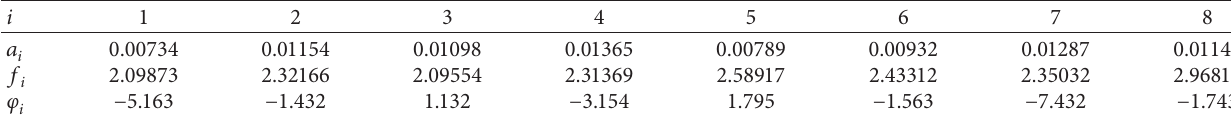
Table 7: Values of 24 fitting parameters in equation (1) in 120 ∼ 140s.